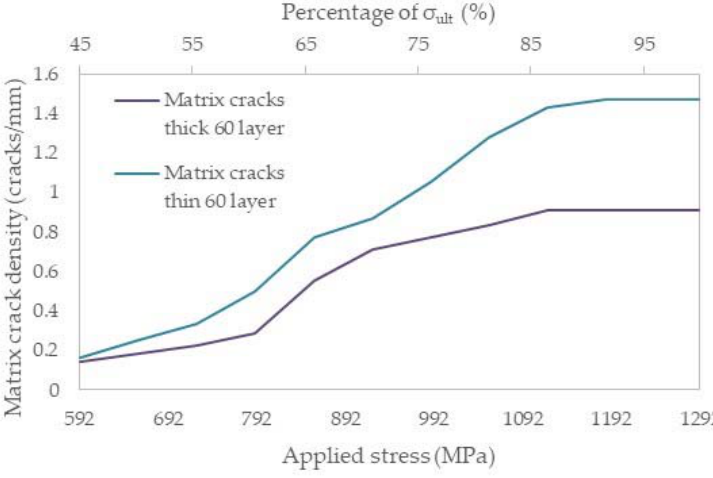
Figure 12. Increase of matrix crack density in the [0°/60°] 2s laminates.